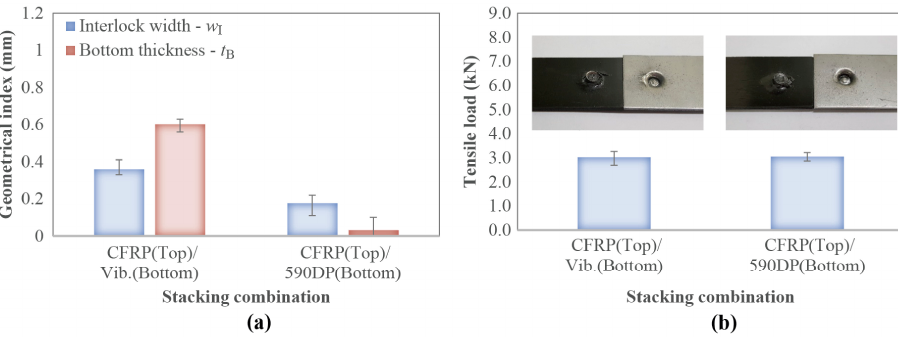
Figure 13. ( a ) w I and t B and ( b ) tensile shear loads for self-piercing riveted joints between vibration- damping steel and CFRP under di ff erent panel stacking con fi gurations.